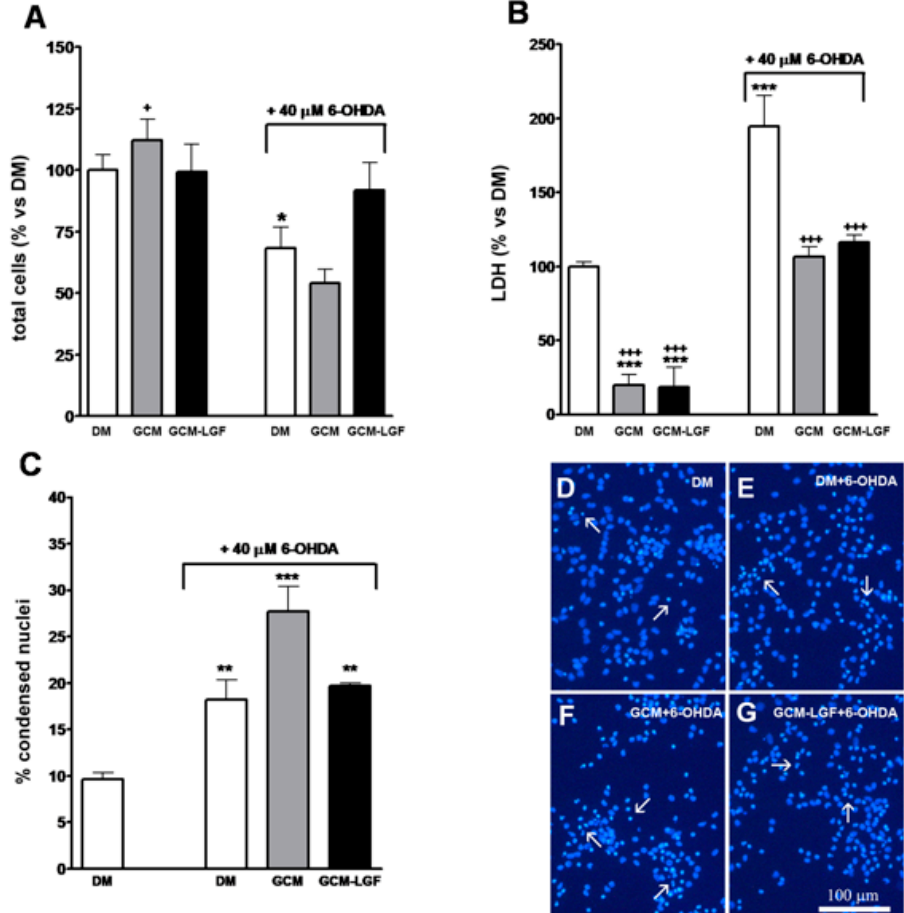
Figure 7. Effects of glial-conditioned medium from LGF-treated glial cultures (GCM-LGF) on lactate dehydrogenase (LDH) activity and neuronal degeneration in mesencephalic neurons damaged with